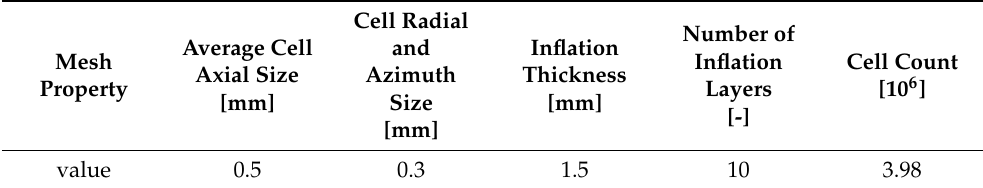
Figure 13. Average axial velocities at three points, along with the air gap and rotor shear stress results used in the mesh independence study. The points are located 20, 40 and 60 mm from air-gap entry. Table 6. The suitably refined mesh for considered flow conditions from Lee [6].